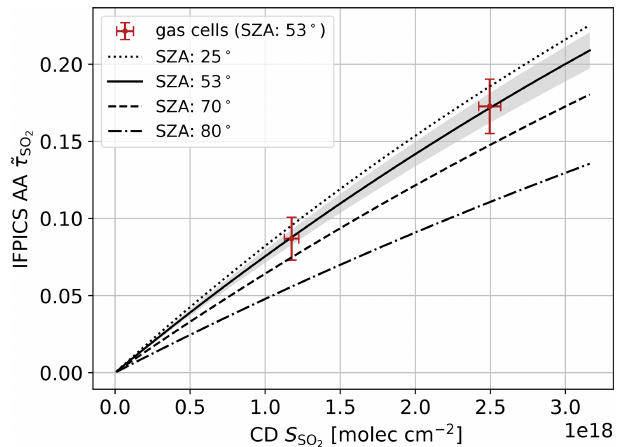
Figure 4. The validation measurement with two SO 2 gas cells (red, with 1 σ error) with the IFPICS prototype and by DOAS on 21 July 2019, 11:10–11:20CET, with a solar zenith angle (SZA) of 53 ◦ . The instrument forward model (Eqs. 2–7) is used to calculate the IF- PICS AA ˜ τ SO for a given CD S SO range. The model input param- 2 2 eters are shown in Table 1, and ( 335 ± 5 ) DU is used as VCD O . The 3 calculated model output (black) is shown for four different SZAs (25 ◦ , dotted; 53 ◦ , drawn; 70 ◦ , dashed and 80 ◦ , dashed–dotted). The model output and the validation measurement are in good agree- ment if a model SZA of 53 ◦ is used, which is equivalent to the SZA during the measurement time. The model uncertainty is shown by the grey